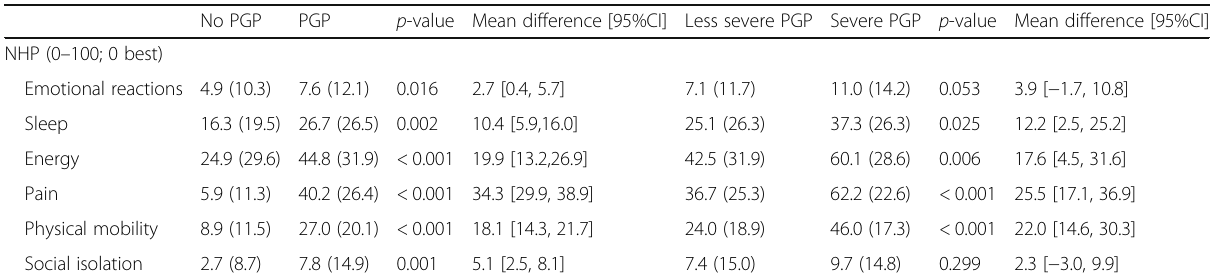
Table 5 Differences between groups of women with and without self-reported PGP, and women with severe and less severe PGP on the NHP, using Mann-Whitney U tests to calculate mean difference and confidence intervals from bootstrap analyses (via